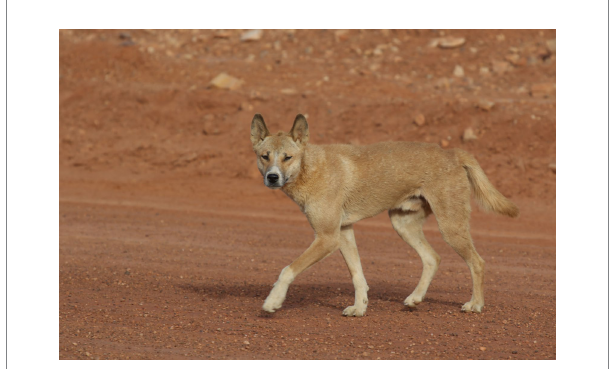
FIGURE 1 The Australian dingo ( Canis dingo ). Source: B. Smith. Reproduced with